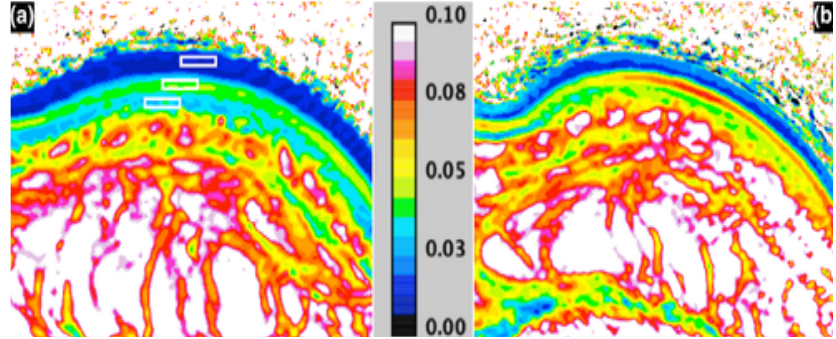
Figure 3. MRI T2 mapping (seconds); ( a ) before—with ROI’s in the stratum corneum, epidermis and dermis; and ( b ) 1 h after moisturiser application